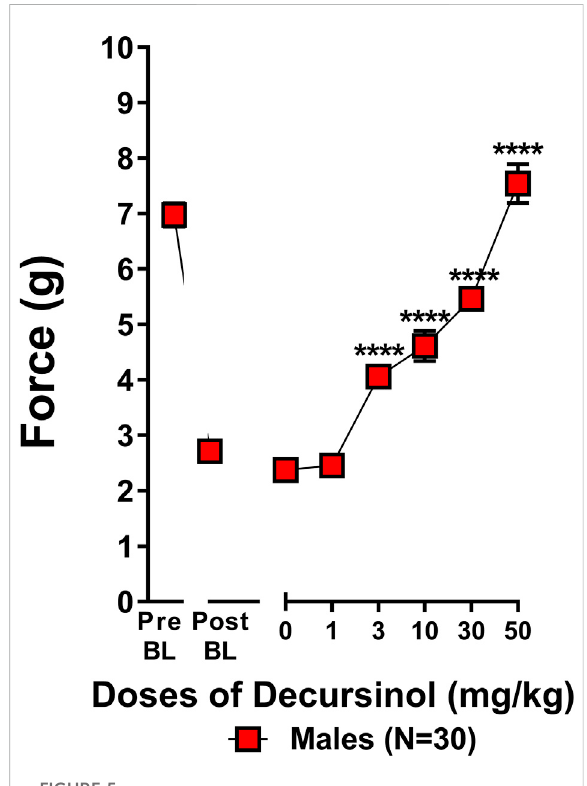
FIGURE 5 Decursinol dose-dependently reverses cisplatin-induced mechanical allodynia in neuropathic male mice. Dose-response curves were generated using male mice to assess the anti- allodynic effects of decursinol in mice with cisplatin-induced neuropathy.MicewereassessedviathevonFreyfortheamountof force (in grams) required to elicit a paw withdrawal response prior to cisplatin treatment (Pre BL), following cisplatin-evoked neuropathy (Post BL), and 30 min following treatment with either vehicle (0) and 1, 3, 10, 30, and 50 mg/kg decursinol (DOH; N = 30).Errorbarsrepresentsthemean±SEM.Eachmousewastested in triplicate per dose, and these values were averaged into a single value per mouse per day of testing. Data were analyzed using a repeated-measures one-way ANOVA with Bonferroni post-hoc tests. (**** p < 0.001 compared to